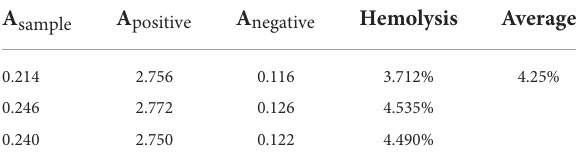
TABLE 3 Hemolytic activity of